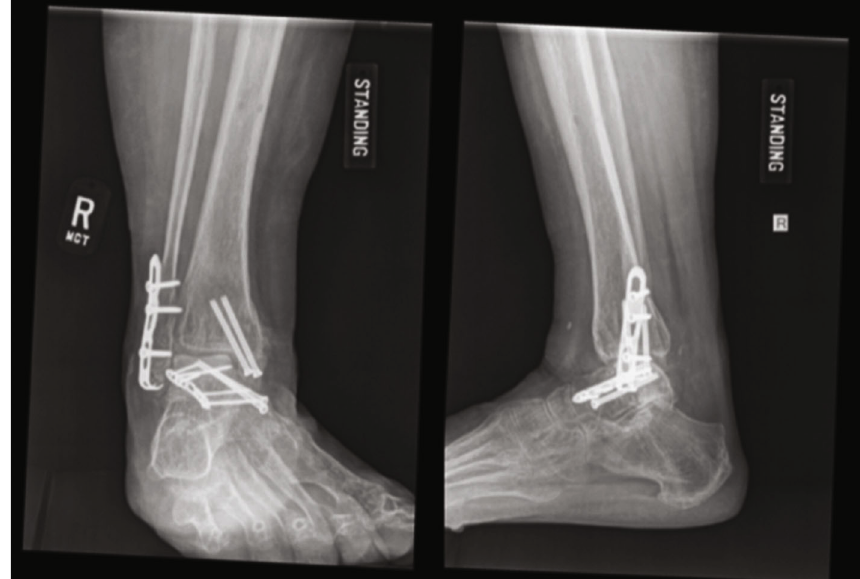
Figure 4: 1-year follow-up; radiographs demonstrated union of fractures, early subtalar and tibiotalar arthritis, and improvement of prior sclerosis of talus without signs of collapse of talar